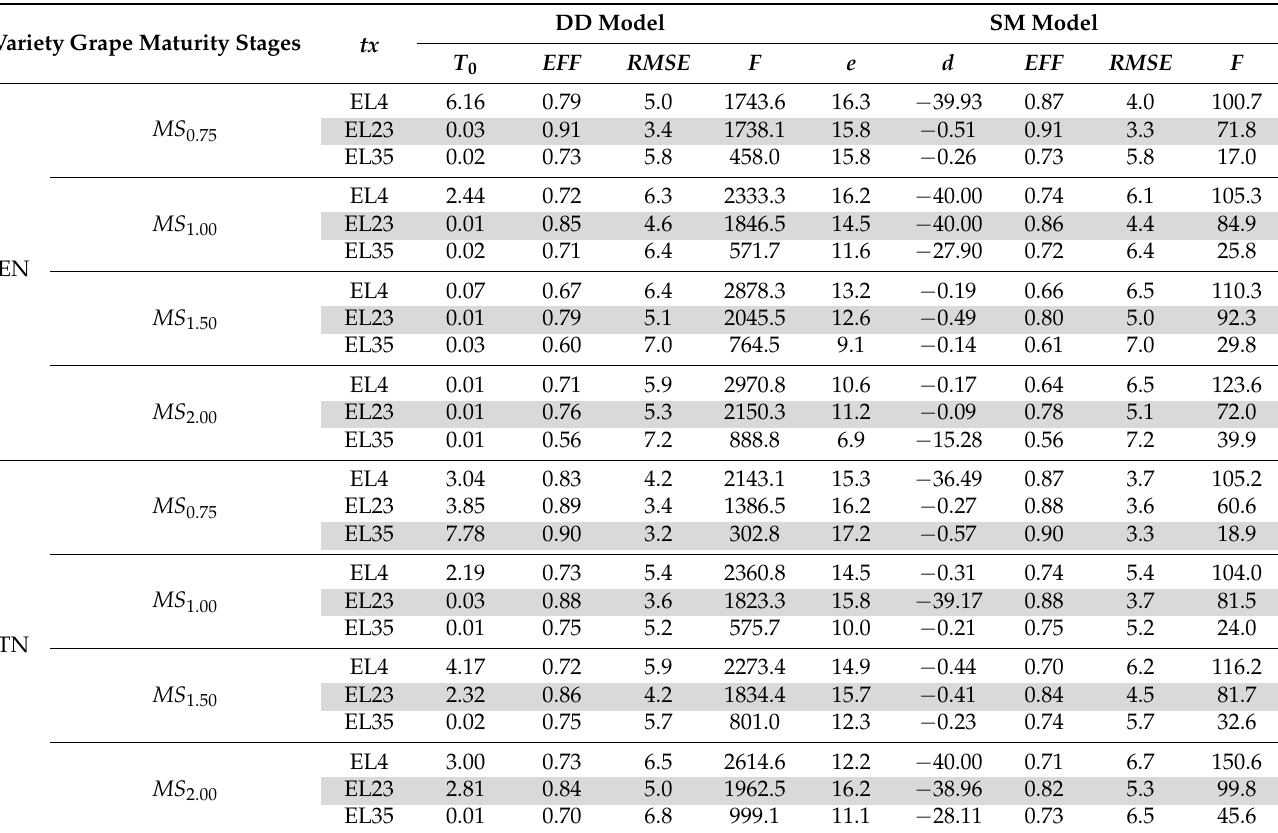
Table 2. Performance statistic criteria and coefficients of the best-fit DD and SM models (with all forcing rate parameters fitted) to predict the DOY to reach the four grape maturity stages ( MS 0.75 , MS 1 , MS 1.5 , and MS 2 ) of TN and EN varieties, using EL4, EL23, and EL35 dates as starting date for heat